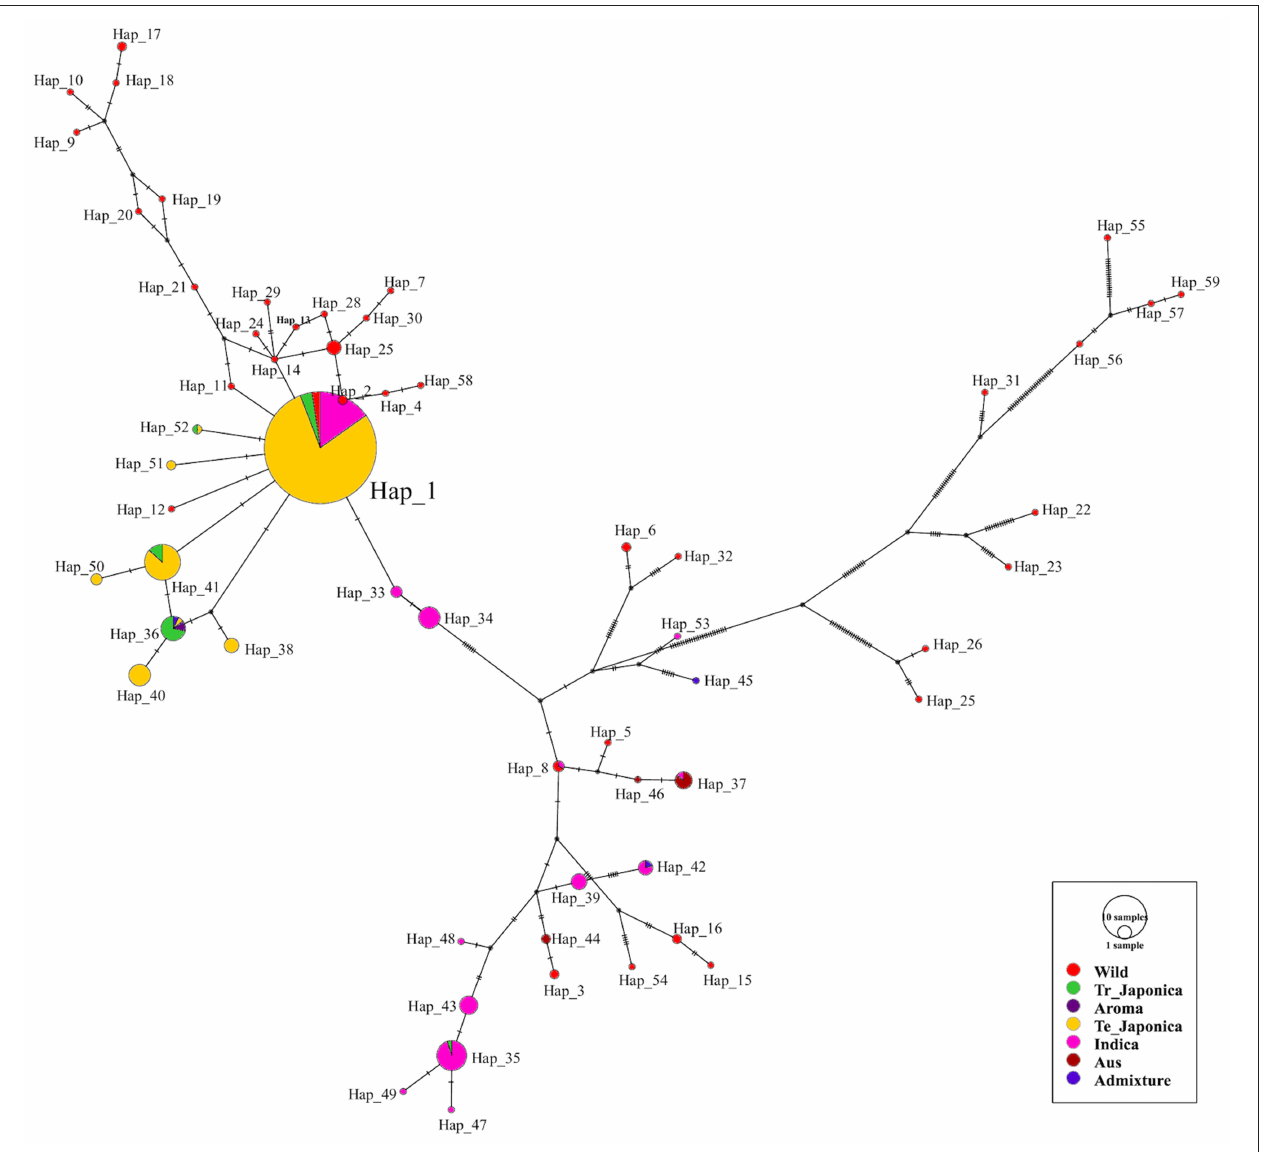
FIGURE 5 | Haplotype network visualizing the evolutionary relationships between different genotypes of the GBSSI gene in 475 accessions of Korean rice collection. The size of each circle is proportional to the number of accessions that harbor the haplotype, and different colors refer to the ecotypes. The median vector indicated by the black circular dot is a hypothetical sequence used to connect the existing similar sequence (Bandelt et al., 1999). In the present analysis, there were 20 median vectors in